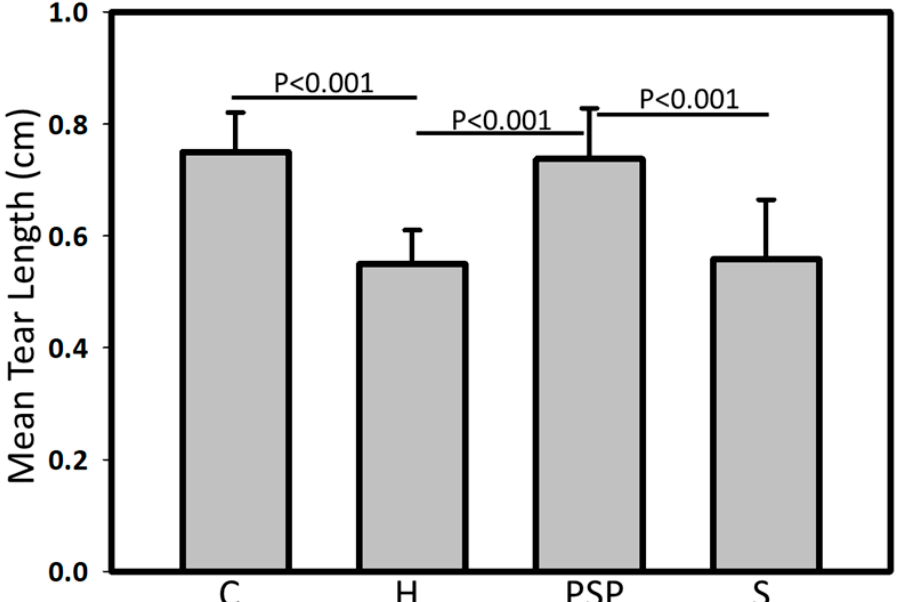
Figure 1. PSP treatment preserved tear secretion capacity in HFD-treated rats. The animals were treated with a high-fat diet (HFD) alone or supplemented with PSP (5%) or atorvastatin (S) for 19 weeks. Before sacrifice, 12 eyes in each group were performed Schirmer’s test to measure the tear secretion. Results were represented as the mean ± SD; p values were denoted to show the significant differences.